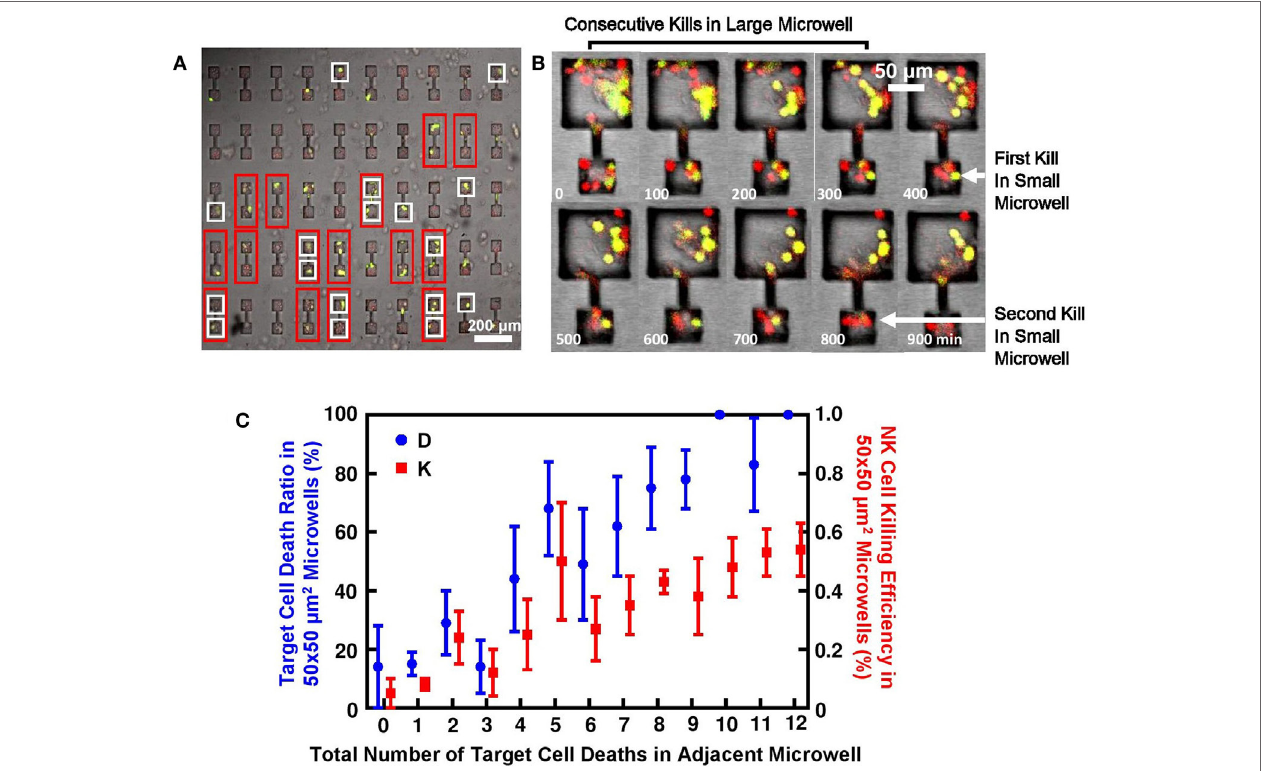
FigUre 5 | Target lysis by natural killer (NK) cells directly affected cell deaths in adjacent microwell connected by microchannel. (a) MCF7 cells had high tendency to die in pairs in 2–50 μ m × 50 μ m connected microwells. Microwell pairs outlined by red frame had MCF7 cells successfully seeded in both sides; microwells outlined by white frame had at least one target lysis; no target death is observed in remaining microwells. (B) Time sequence of MCF7 cells being attacked in connected microwells. First kill in 50 μ m × 50 μ m microwell happened after consecutive target cell lysis in 100 μ m × 100 μ m microwell. (c) Target cell death in microwell increased NK cell cytotoxicity in connected microwell. Y -axis is MCF7 cell death ratio D and NK cell killing efficiency E in 50 μ m × 50 μ m microwells; X -axis is number of target lysis in adjacent larger